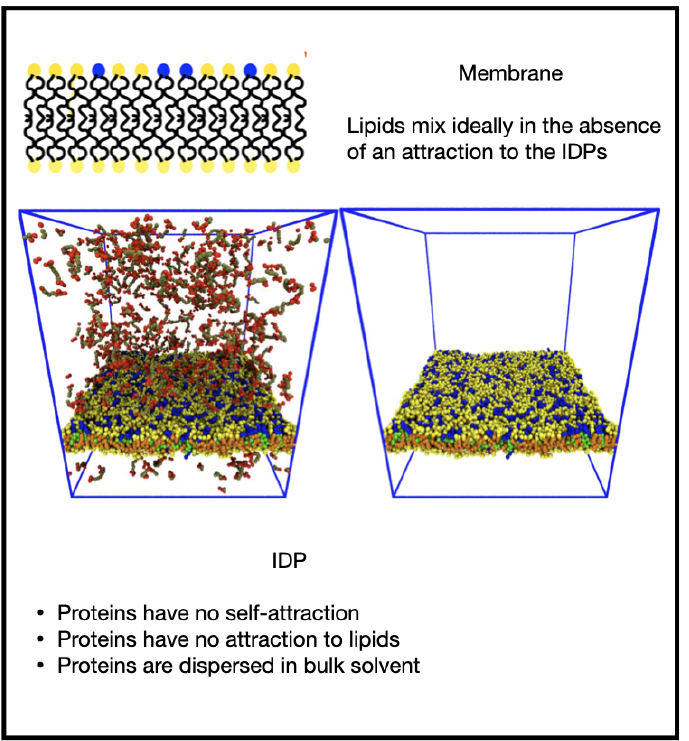
Figure 4. Equilibrium state of the system when both the IDP endcap self-attraction and attraction to the minority phase lipid headgroups are zero (solvent particles are invisible for